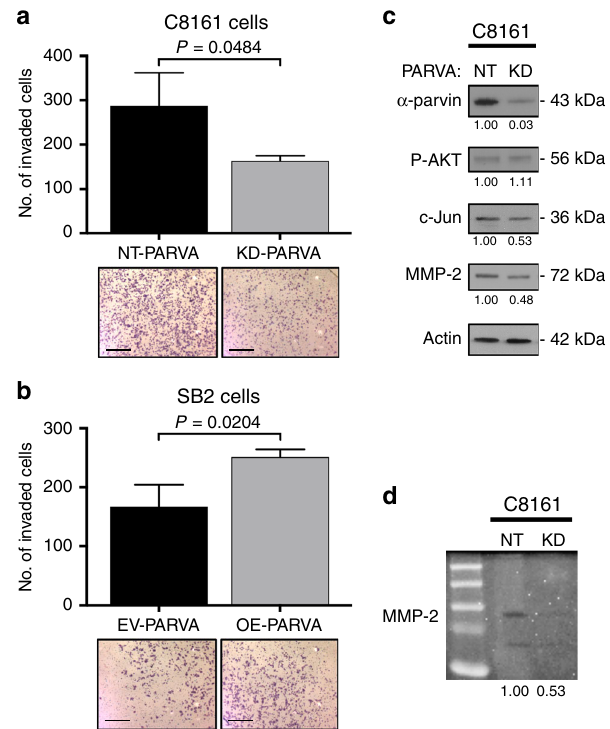
Fig. 3 The role of PARVA in melanoma cells invasion. a C8161 KD- PARVA cells showed a signi fi cant reduction in the number of invaded cells ( P = 0.0484, two-tailed Student t test) compared to NT- PARVA . Scale bars represent 200 µ m. b SB2 overexpressing (OE)- PARVA cells resulted in an increased in the number of invaded cells ( P = 0.0204, two-tailed Student t test) when compared to SB2 control (EV) cells. Scale bars represent 200 µ m. c Western blot analysis of C8161 cells non-targeting (NT) or knockdown (KD) for PARVA. KD of PARVA in C8161 cells revealed a decreased in the protein levels of c-Jun and MMP2 but no changes in phosphorylation of AKT. d Zymography analysis of C8161 cells shows a reduction in the activity of MMP-2, in PARVA KD cells. All panels are representative of three independent biological